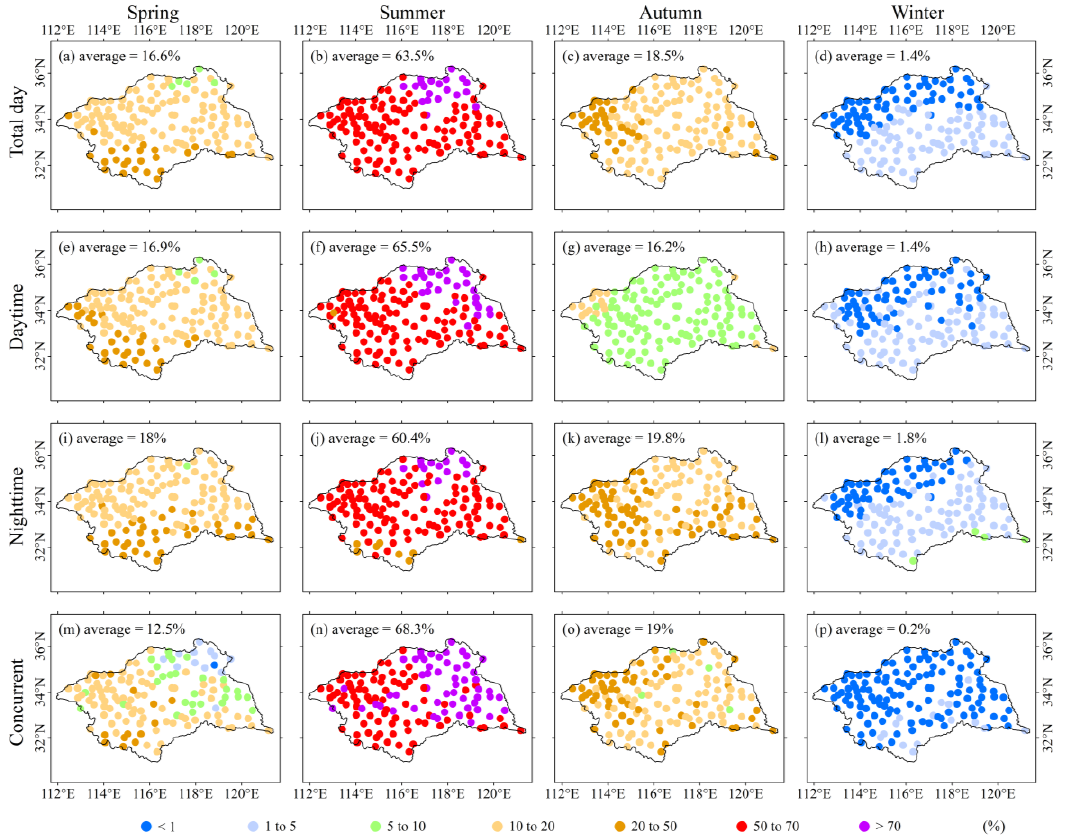
Figure 17. The proportions of ( a – d ) TR90p, ( e – h ) DR90p, ( i – l ) NR90p, and ( m – p ) CEDNP